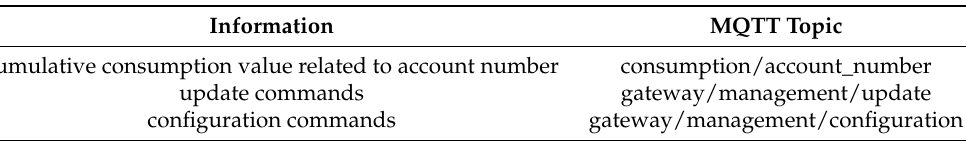
Table 2. Topic structure for MQTT messages.